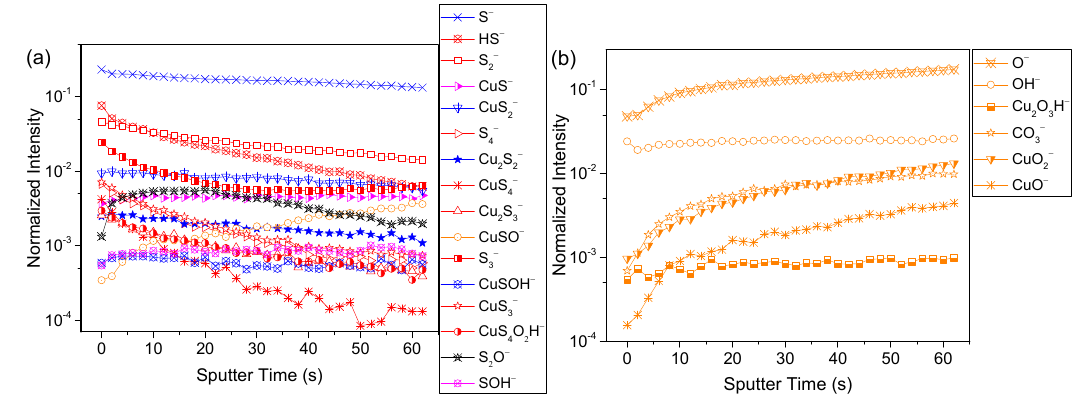
Figure 6. Depth profile curves for negative ions of sulfidized malachite: ( a ) sulfur-containing negative fragment ions and ( b ) oxygen-containing negative ions and Cu + fragments.